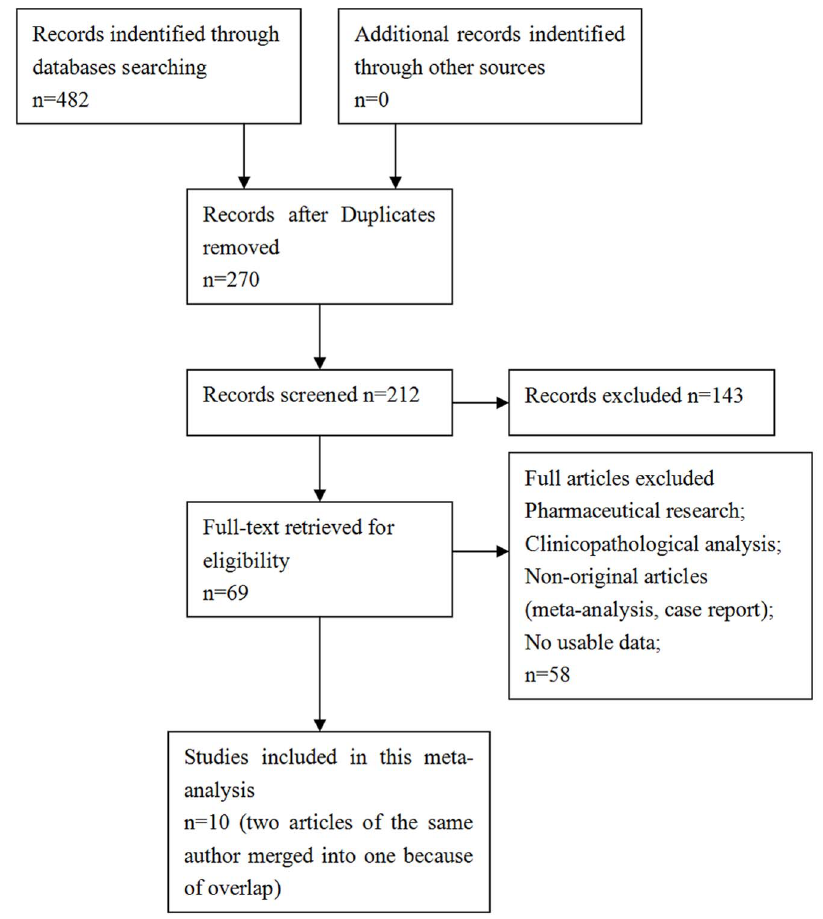
Figure 1. Flowchart presenting the steps of literature search and selection.